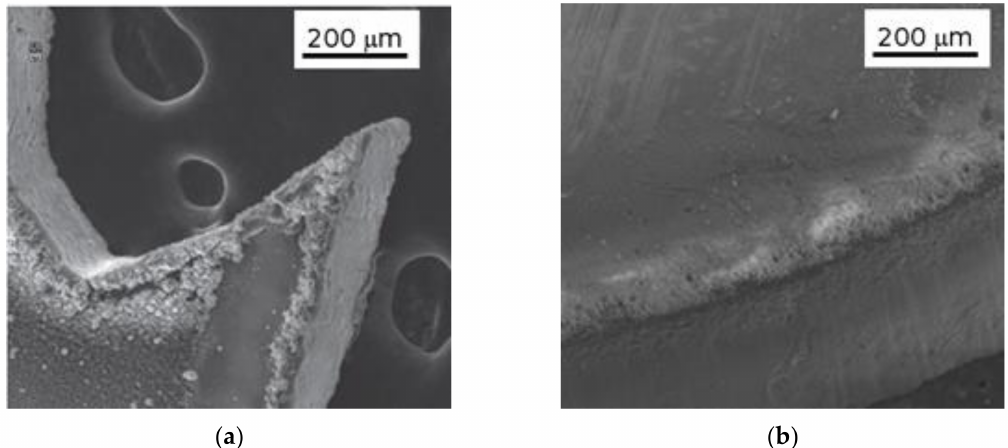
Figure 4. SEM image of laser modified photovoltaic cells—( a ) fragments of sharp point of an element and ( b ) the edge of the